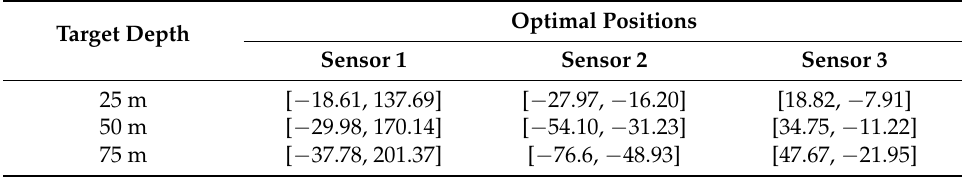
Table 3. Optimal Positions of Sensor AUVs (Single Target: DSP) and Effect of Target Depth on Optimal Formation.